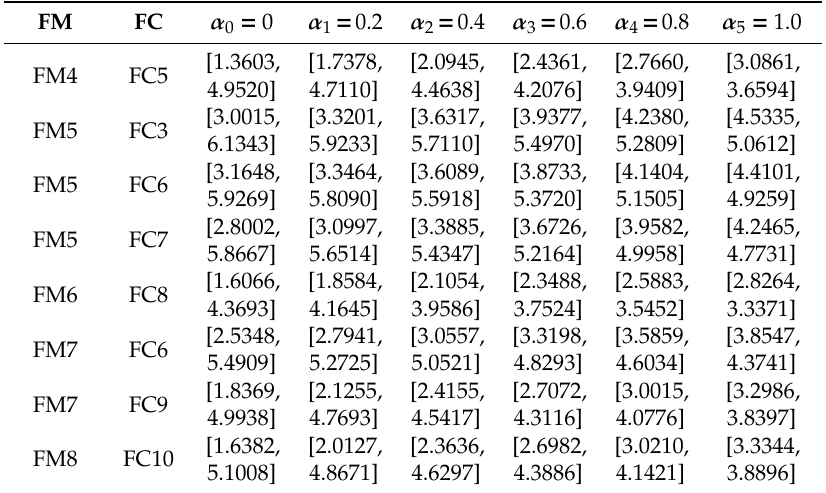
Table 8. Alpha-level sets of fuzzy RPNs for a permanent magnet synchronous